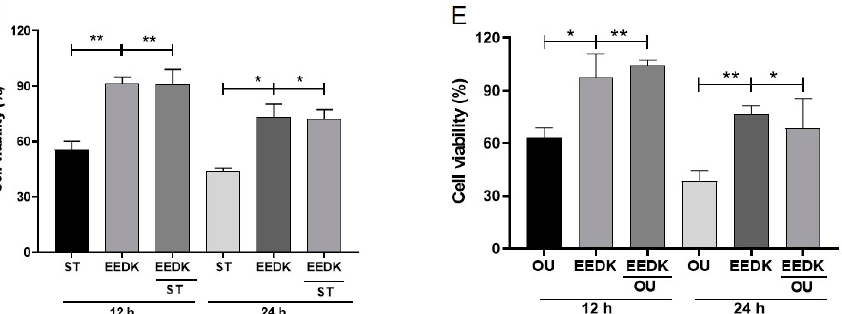
Figure 1. Optimization of cytotoxic drugs concentration and viability of HCECs under the influence of ST and OU with or without EEDK. HCECs were exposed to ( A ) ST and ( B ) OU, and ( C ) levels of EEDK were also optimized. EEDK co-treatment with ( D ) ST and ( E ) OU. Data are presented as the mean ± standard error mean (SEM) of values from four representative experiments. * p < 0.05, ** p < 0.01, *** p < 0.001, **** p < 0.0001 for the indicated comparisons (one-way ANOVA with Dunnett’s multiple comparison test).